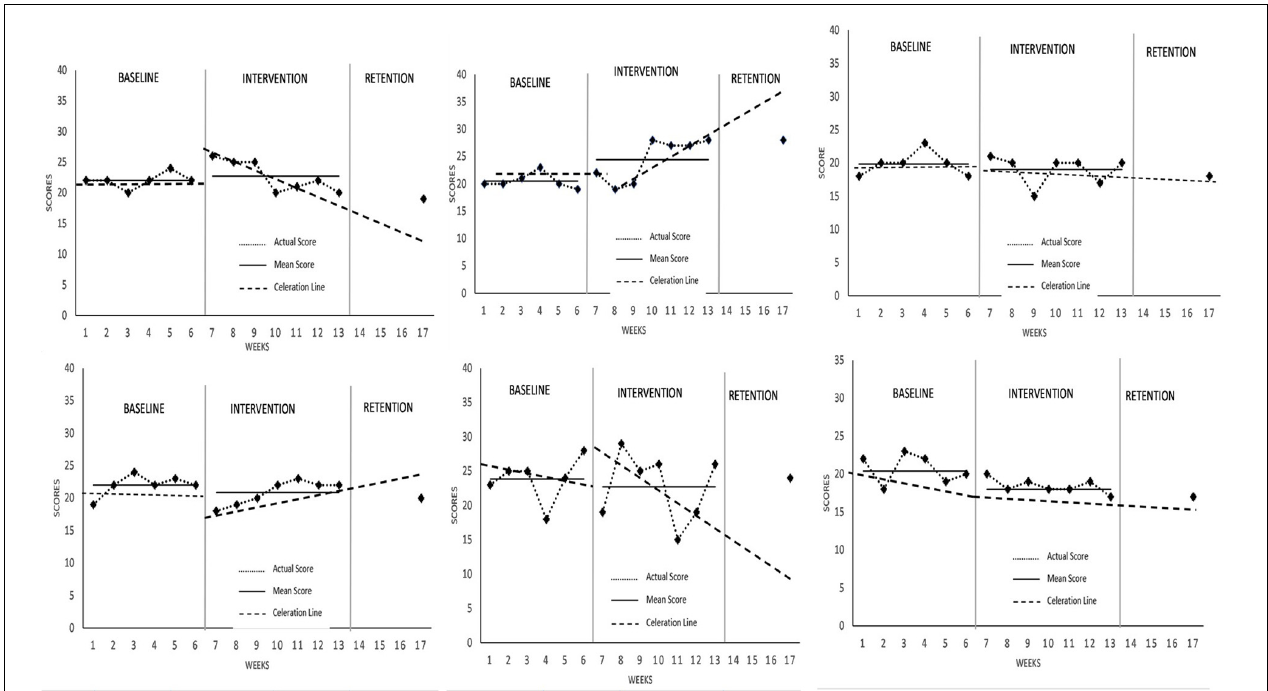
FIGURE 3 | Perceived stress scale (PSS) scores across all